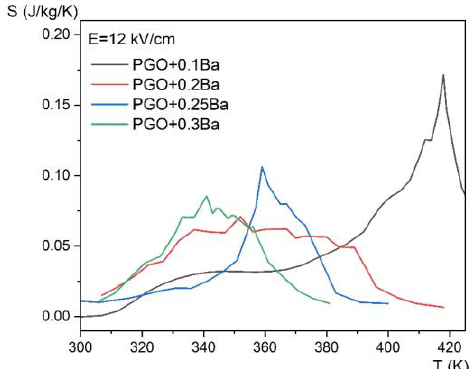
Figure 10. Entropy change as a function of temperature, for E = 12 kV/cm for PGO + xBa crystals: PGO + 0.1Ba, PGO + 0.2Ba, PGO + 0.25Ba, PGO + 0.3Ba.